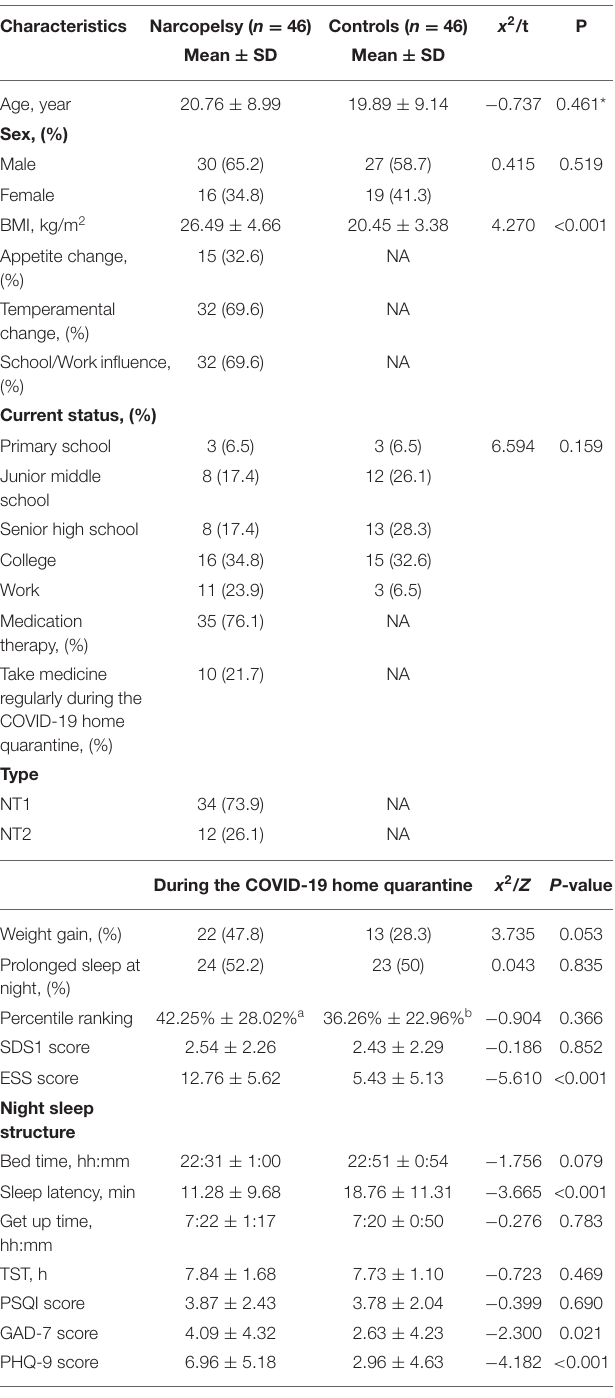
TABLE 1 | Baseline characteristics and different sleep patterns of narcolepsy patients and controls. Characteristics Narcopelsy ( n = 46) Controls ( n = 46) x 2 /t